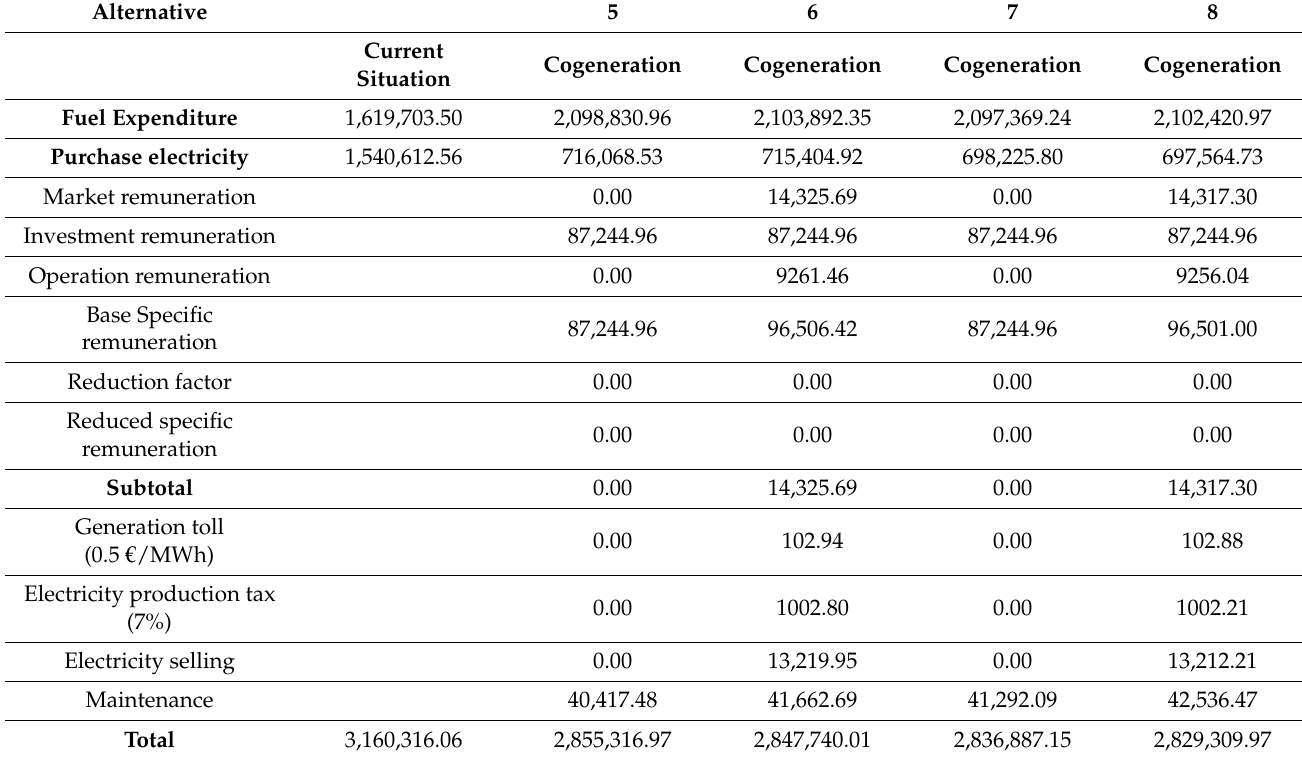
Table A6. Economic Balance ( € /year) for alternatives considering 1 MW fuel cell power.